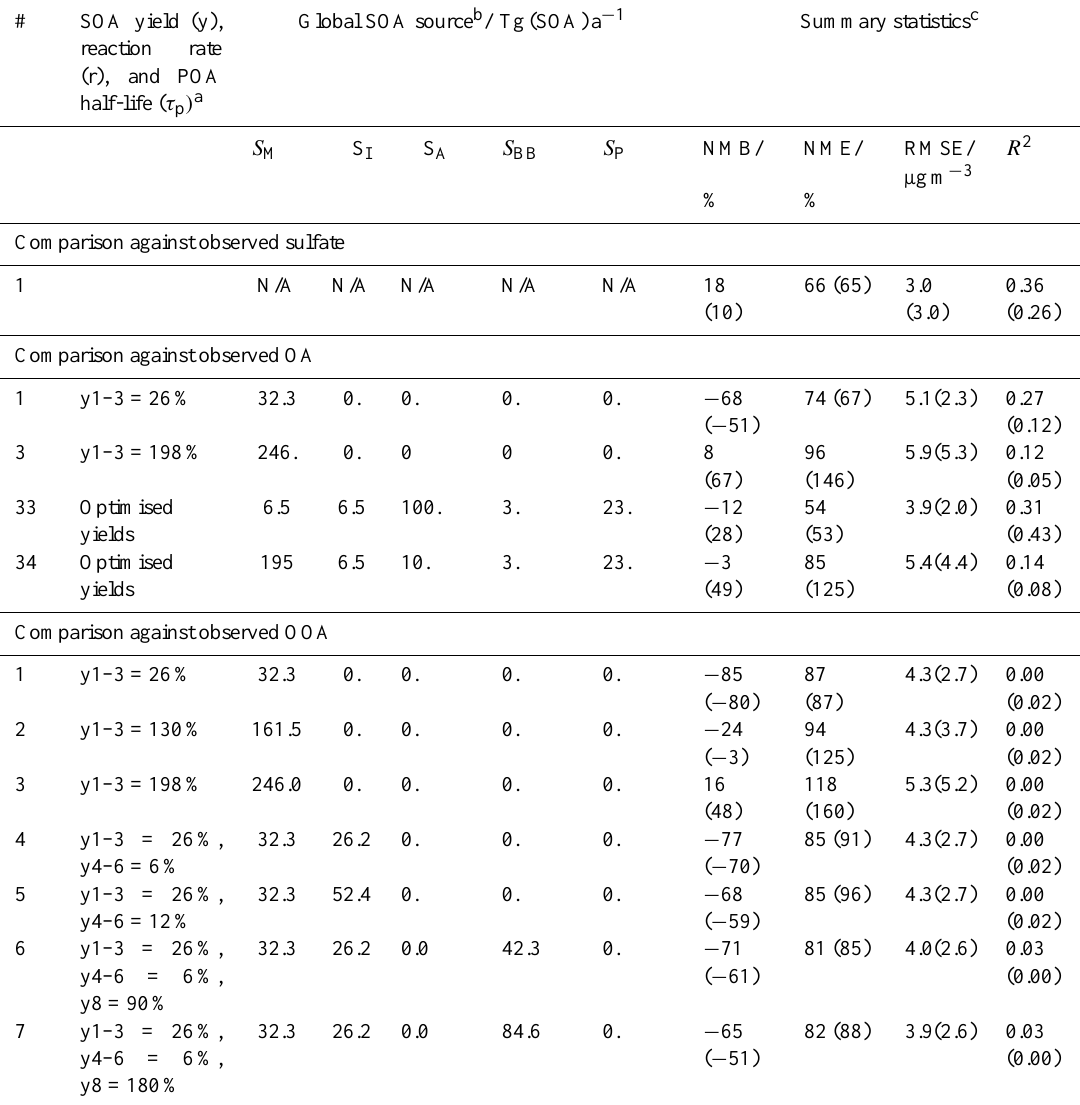
Table 2. Summary statistics for the evaluation of simulated sulfate, OA, HOA and OOA against AMS observations. Comparison at AMS locations classified as remote (see Sect. 2.3) given in parenthesis. The SOA source from monoterpenes ( S M ) , isoprene ( S I ) , anthropogenic VOC ( S A ) , biomass burning VOC ( S BB ) and from oxidation of POA to SOA ( S P ) , are detailed for each